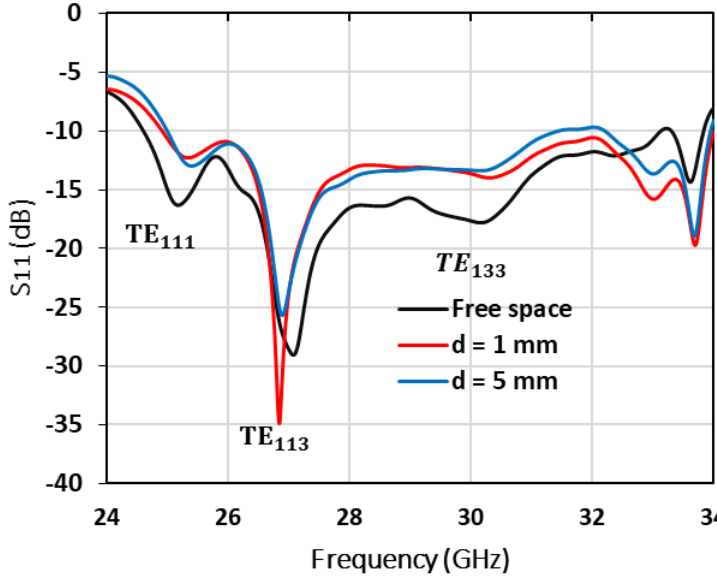
Figure 3. |S 11 | of a DRA in free space and placed next to a phantom.